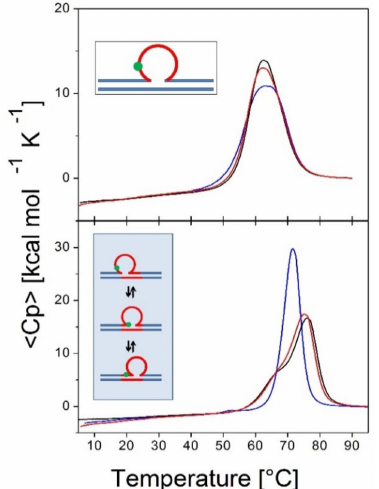
Figure 3. Figure 3 shows the excess heat capacity curves measured for a static (CAG)6 repeat bulge loop (top panel) [50] and dynamic (CAG)4 repeat bulge loop (bottom panel) in the absence (black curve) and presence of either 8oxodG (red curve) or an abasic site lesion (blue curve) in place of dG in the first CAG repeat. Note that whereas the abasic site lesion in the static bulge loop is associated with a slight broadening of the melting transition, but no net change in enthalpy change, it results in the exact opposite melting behavior in the dynamic rollamer construct. In the dynamic rollamer, the abasic site lesion causes the loss of the pre-transition and a significant apparent increase in cooperative melting transition relative to the lesion free rollamer, reflecting lesion induced changes in loop isomer distribution. The excess heat capacity curves therefore provide a good window into the impact of lesions on dynamic loop distributions. As reported for duplex DNA [69–71], the impact of 8oxodG lesions in either the static bulge loop or dynamic rollamer is minor.